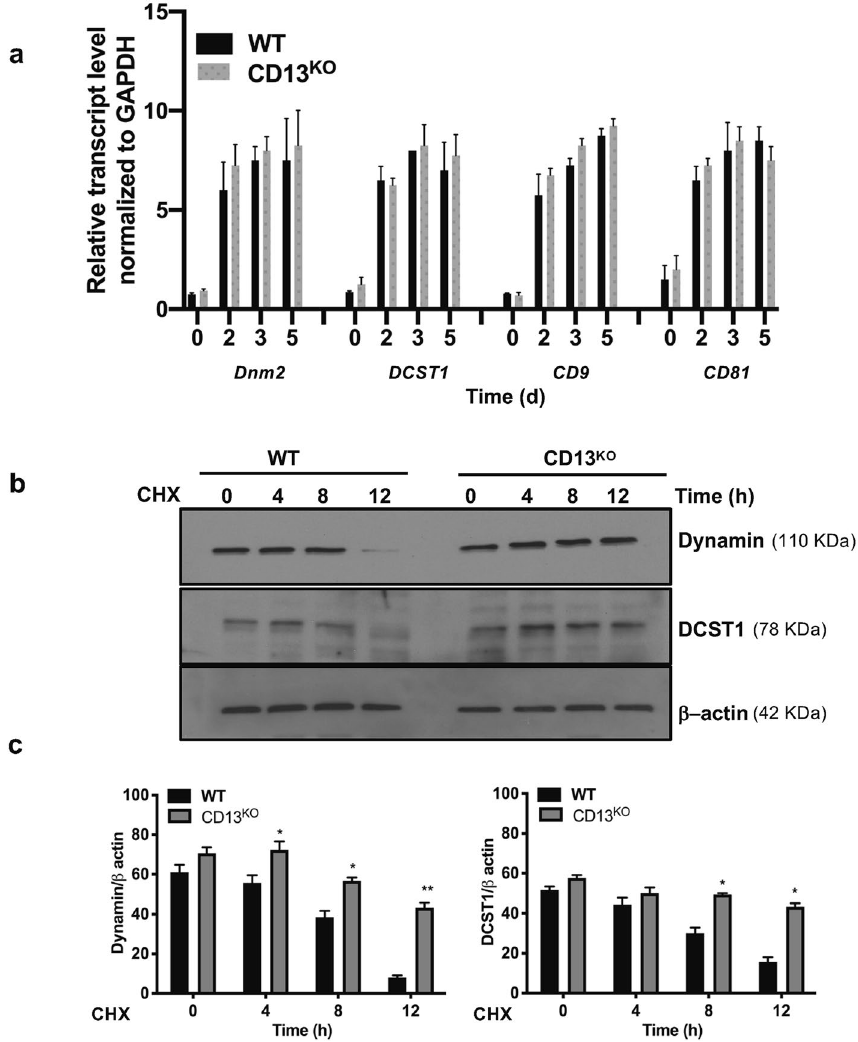
Figure 8. Fusion-regulatory proteins, dynamin and DCST1 are regulated by a CD13-dependent post transcriptional mechanism. ( a ) Quantitative RT-PCR analysis of fusion regulatory transcripts normalized to GAPDH in flow sorted mouse BM cells stimulated with M-CSF and RANKL over indicated time. Expression of the genes regulating osteoclast fusion -dynamin 2 (DNM2), DCST1, CD9 and CD81 are highly induced upon M-CSF and RANKL over time but was equivalent between genotypes. All data was analyzed using CFX Manager version 3.1 ((https:// www. bio- rad. com/ en- us/ sku/ 18450 00- cfx- manag er- softw are? ID= 18450 00) (Biorad). Data represents average of two independent experiments. N = 3/genotype. ( b – c ) Dynamin and DCST1 protein stability are enhanced in absence of CD13. Immunoblot analysis of dynamin and DCST1 of WT and CD13 KO BM-derived OC treated with cycloheximide (CHX) for indicated time. Blots were imaged by ChemiDoc Imaging system version 3.0.1 (https:// www. bio- rad. com/ en- us/ categ ory/ chemi doc- imagi ng- syste ms? ID= NINJ0 Z15) (Biorad). A cropped image is presented, see Supplementary Fig. S10 for full-length blots and cropped replicates. Data represents average of two isolates. N = 3/genotype. **p < 0.01, *p <